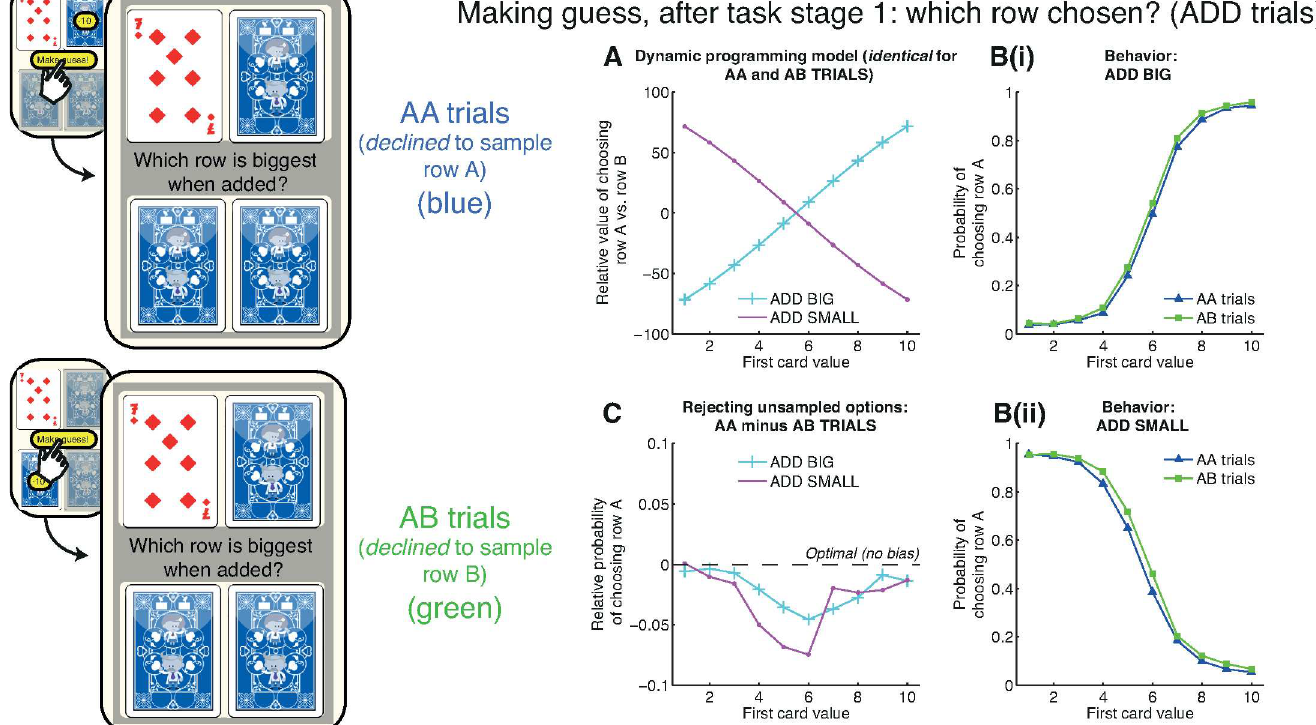
Fig 3. Rejecting unsampled option bias at the Choice Stage. If subjects choose to guess at Task Stage 1, they then select between row A and row B. (A) Model predictions. The relative expectedvalue (in points) of choosingrow A versus row B in the ADD BIG (cyan) and ADD SMALL (purple) conditions. Crucially, the decisionis identicalfor AA and AB trials; the only difference between these conditionsis which row subjects have previously declinedto sample. (B) Subject behavior. The probabilityof choosingrow A shows a softmax relationshipto the relative values shown in Fig 3A. Note that the green line (AB trials) is higher than the blue line (AA trials) at nearly all card values, particularlynear the point of subjective equivalence. (C) Rejecting unsampledoption bias is revealed by subtracting AB trials from AA trials in both ADD BIG and ADD SMALL conditions. Subjects are more likely to choose row A if they have declined to sample row B. See also S4 Fig and S5 Fig for other conditions. Data for reproducing all analysesis freely availablefor downloadfrom